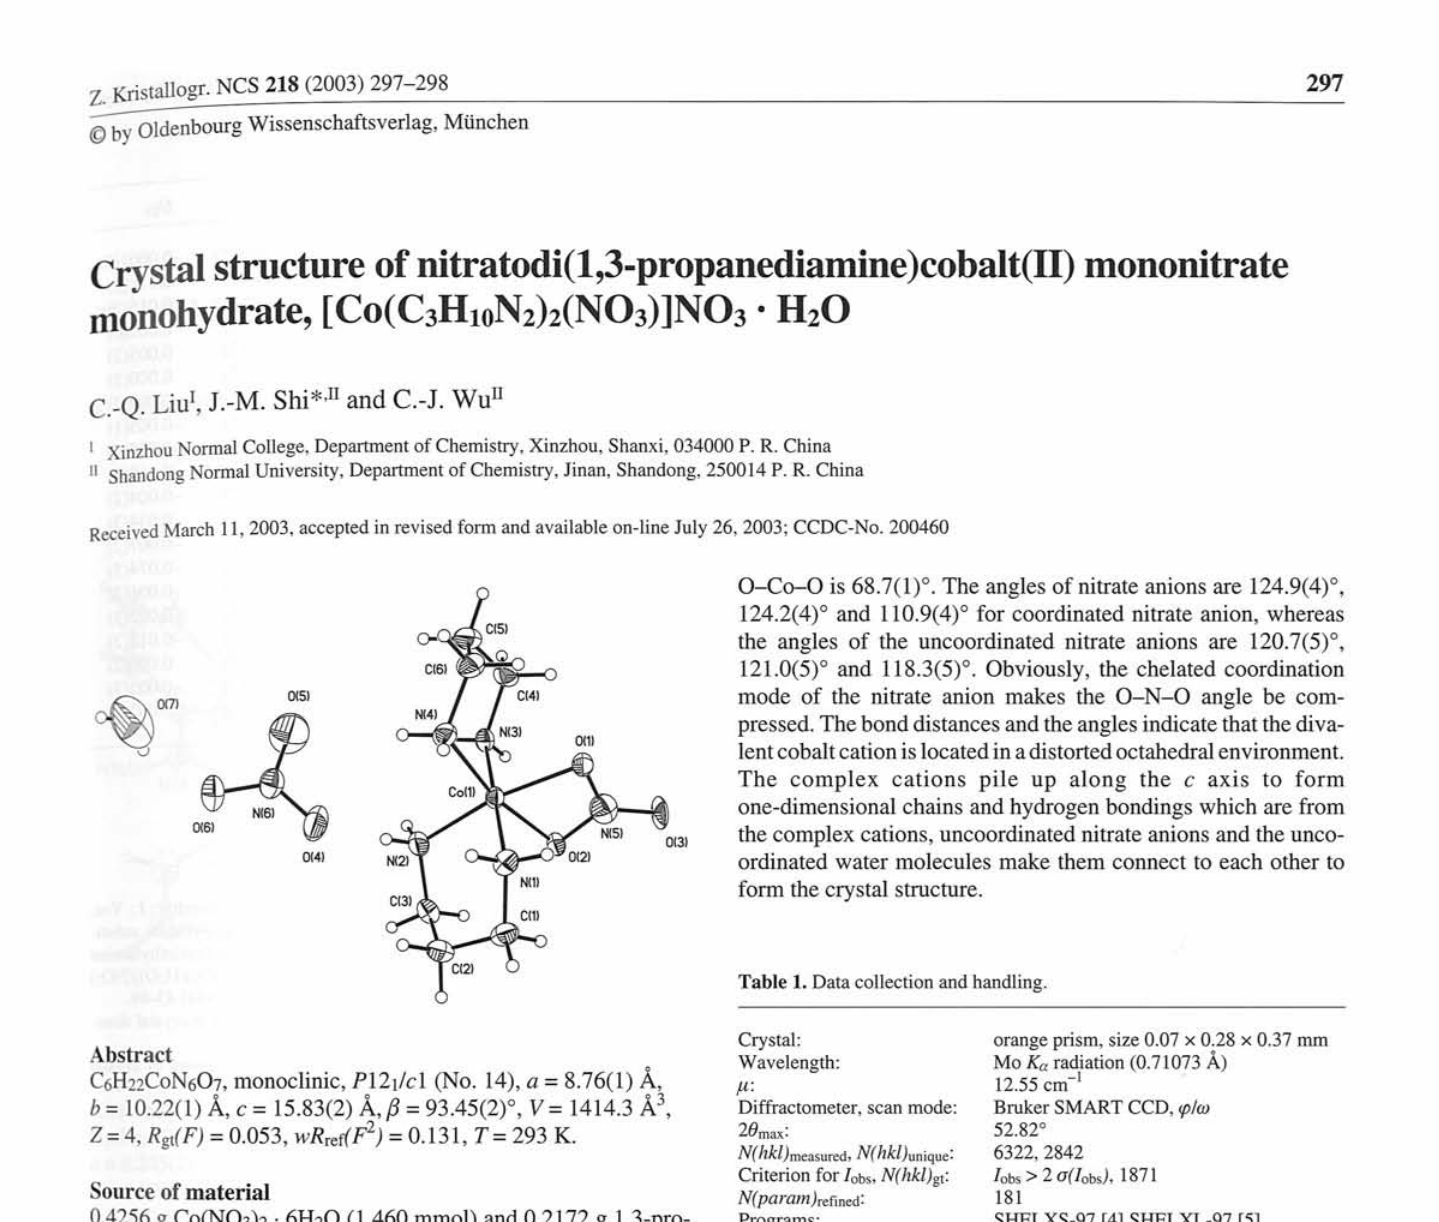
Table 2. Atomic coordinates and displacement parameters (in